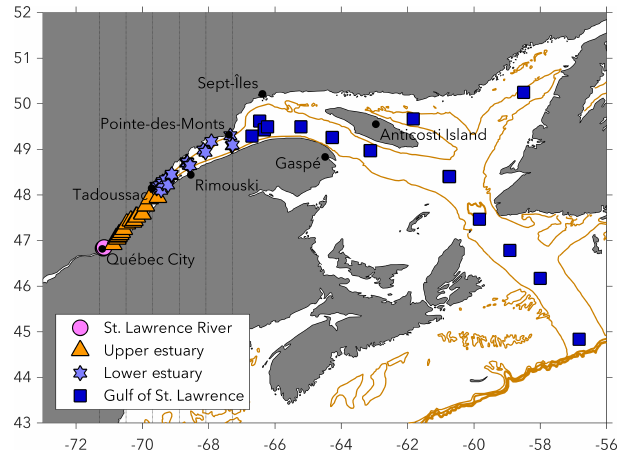
Figure 2. Map showing the four principal subdivisions of the study area and the sampling locations (markers). Water samples were col- lected during 10 spring and summer research cruises: July 2003, June 2006, May 2007, July 2007, June 2009, July 2009, July 2010, May 2011, June 2013, and May 2016. The estuary, from the land- ward limit of the saltwater intrusion near Île d’Orléans ( ∼ 5km downstream of Québec City) to Pointe-des-Monts, where the coast- line diverges, extends ∼ 400km and covers a total surface area of ∼ 12820km 2 . The solid gold line follows the 200m isobath of the Laurentian Channel. The vertical dotted lines delineate the five seg- ments of the estuary used for the calculation of the area-averaged CO 2